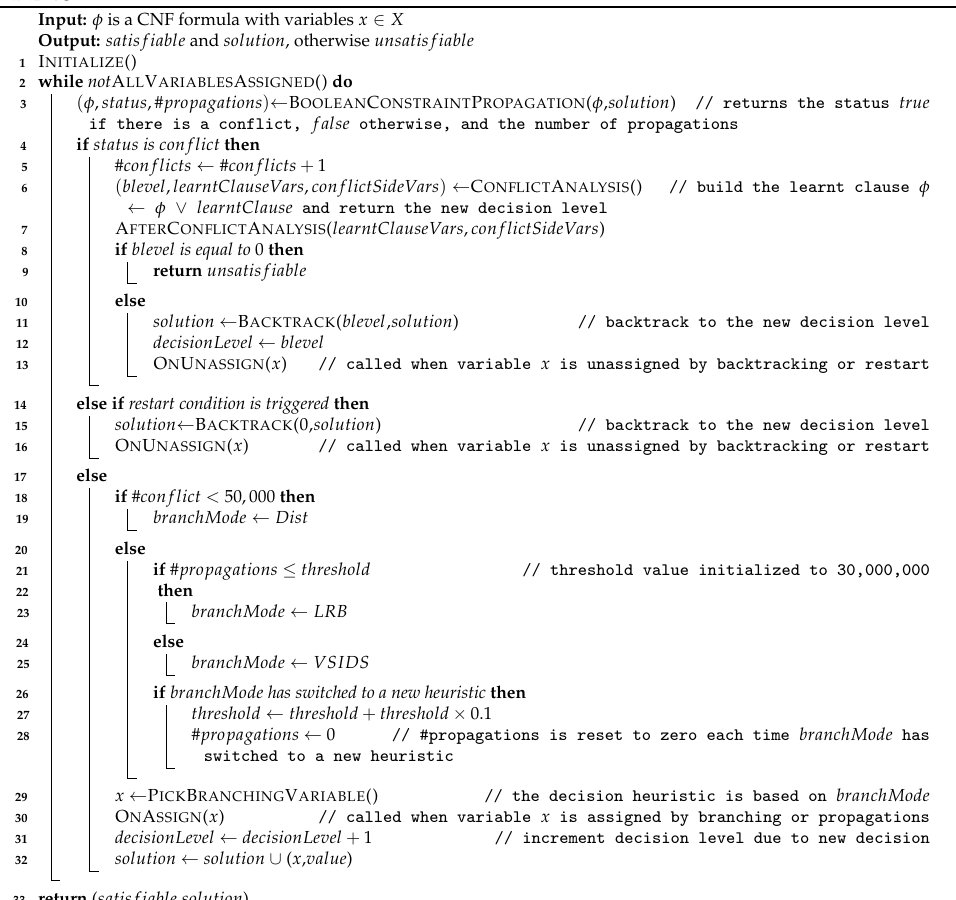
Algorithm 1: Pseudocode for top-level implementation of MapleLCMDistChronoBT-